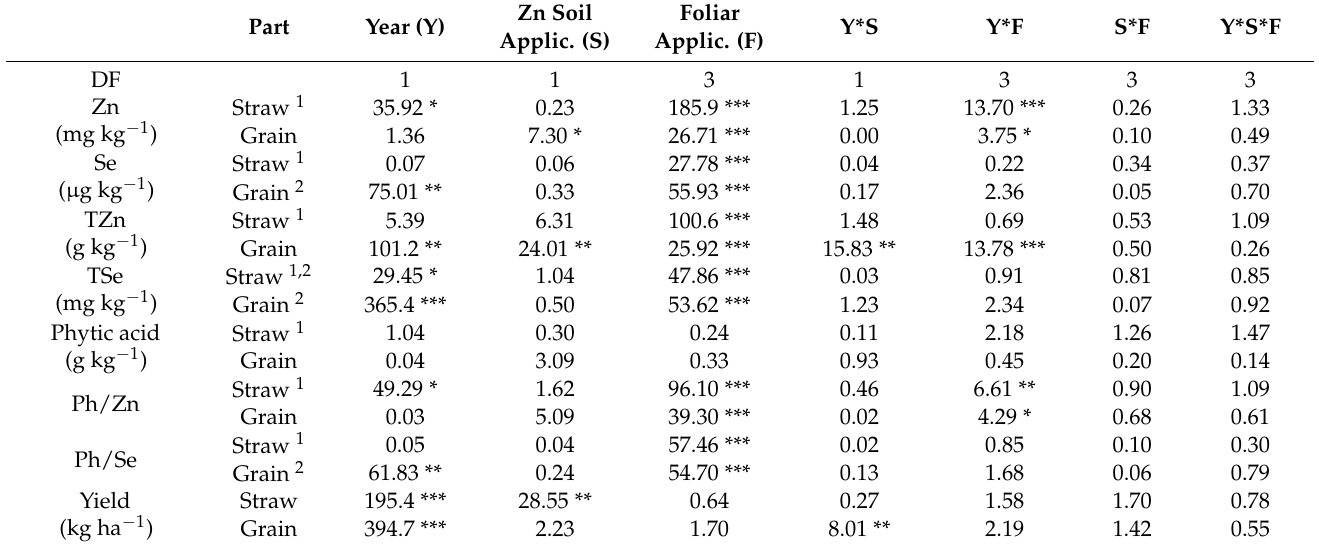
Table 1. Summary of the split-split-plot ANOVAs showing the effect of the main-plot factor (year), subplot factor (Zn soil application), sub-subplot factor (foliar application) and their interactions on each parameter evaluated in straw and grain. DF, degree of freedom; F values, including the level of significance (* p ≤ 0.05, ** p ≤ 0.01, *** p ≤ 0.001) are shown in the rest of the rows.